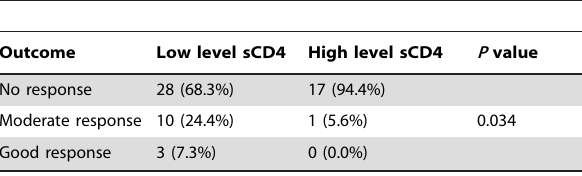
Table 3. Correlation between sCD4 levels in serum and clinical outcomes of RA patients after 3